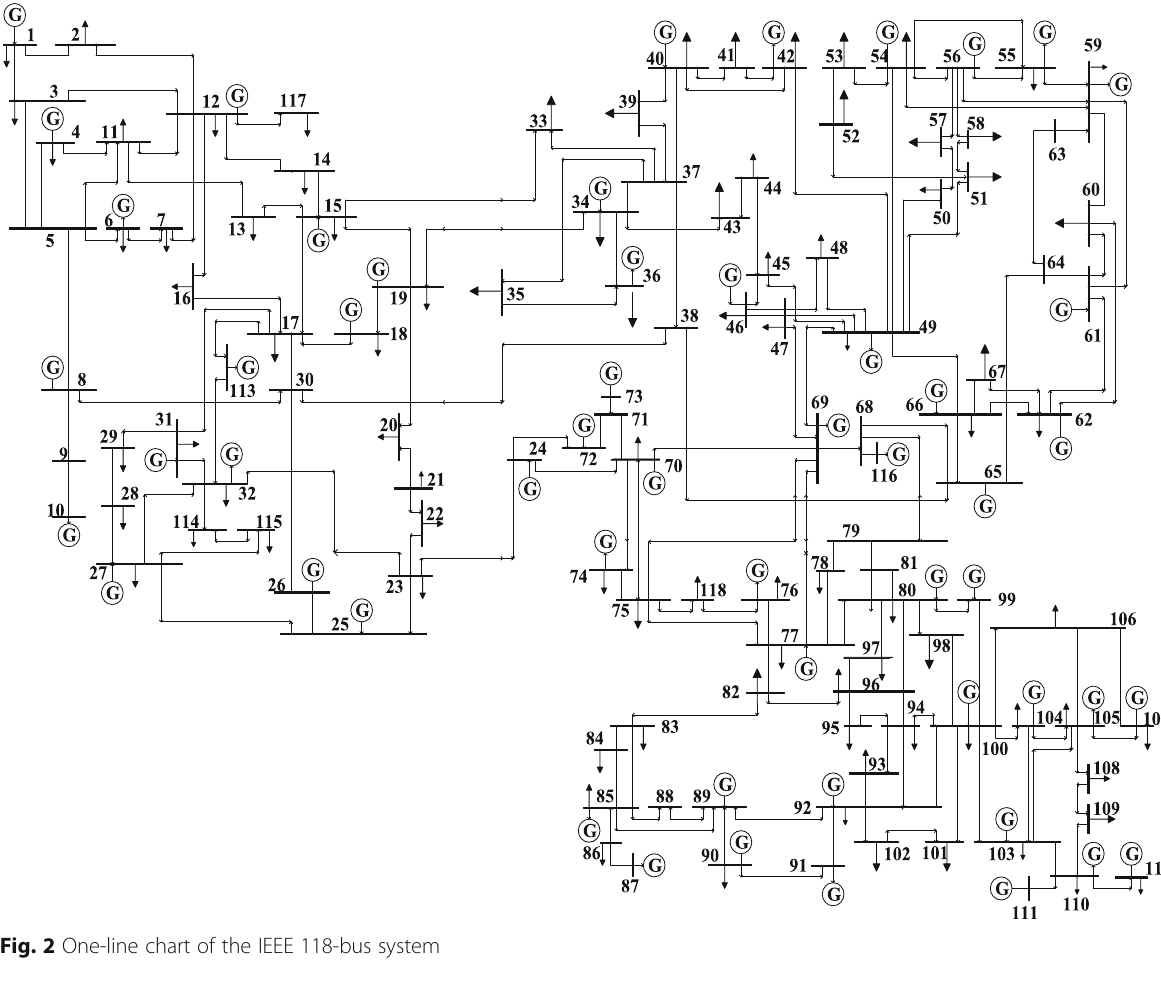
Fig. 2 One-line chart of the IEEE 118-bus